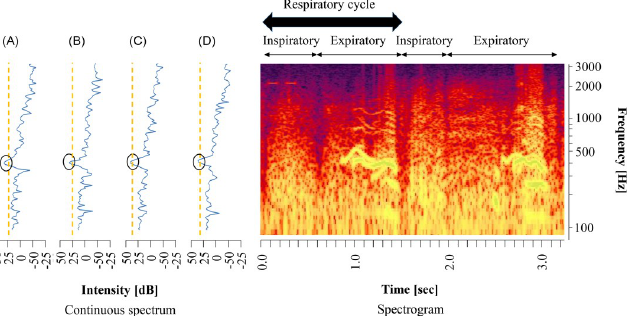
Fig 1. Spectra and spectrograms of wheezes in lung sounds. (a) Spectrum 1: Fast Fourier transform (FFT) frame, 0.682–1.054 s; (b) Spectrum 2: FFT frame, 0.700–1.072 s; (c) Spectrum 3: FFT frame, 0.718–1.090 s; (d) Spectrum 4: FFT frame, 0.736–1.108 s.